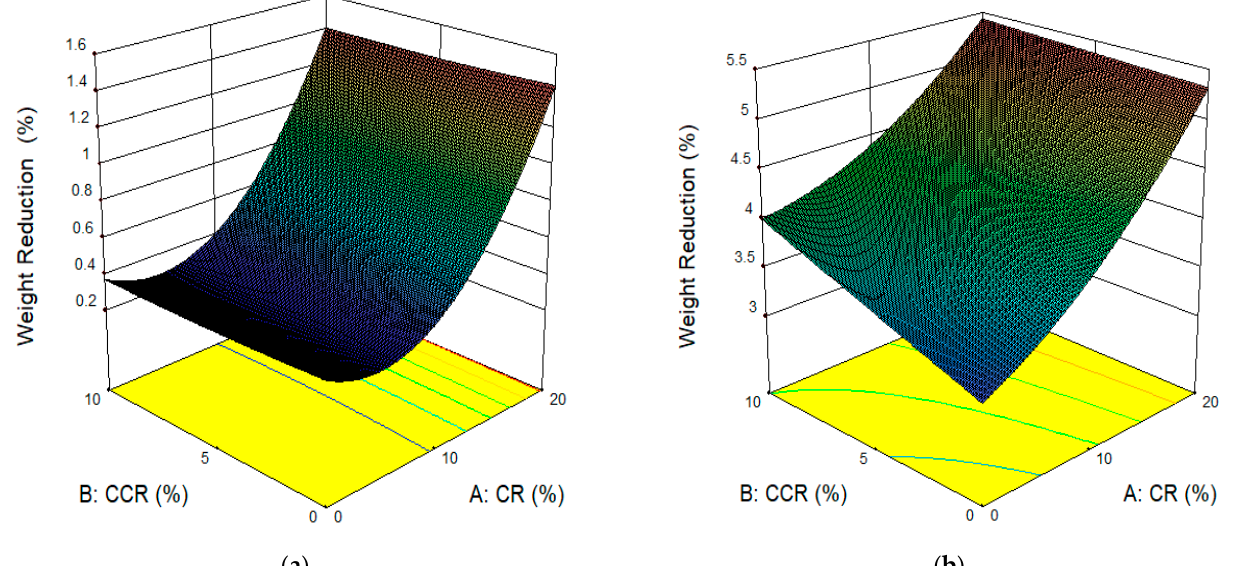
Figure 8. 3D response surface plot for weight reduction models for ( a ) 200 °C model and ( b ) 400 °C model .